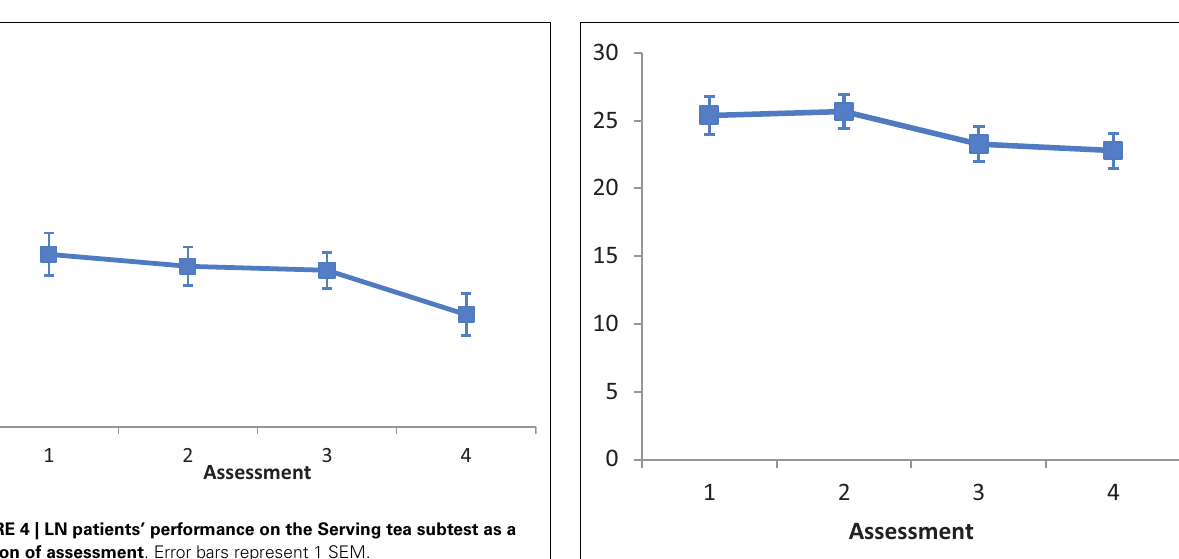
differences among the four levels of Assessment (all p s ns ). The interaction Intervention type by Assessment was not significant, F (6, 84) = 0.581, ns